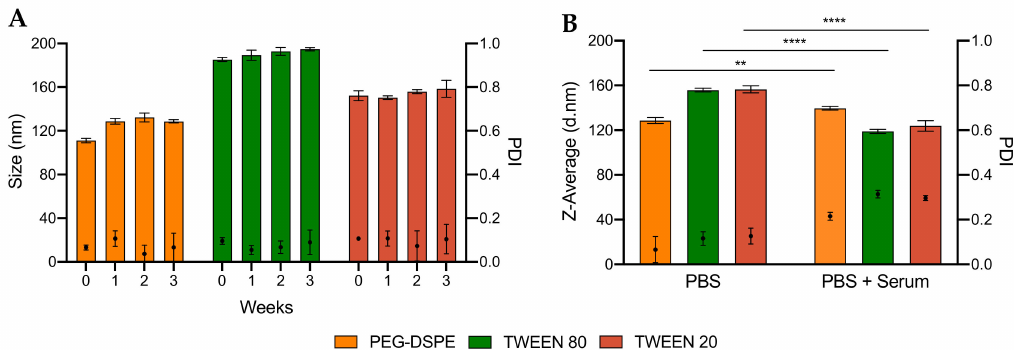
Figure 4. Stability of LNPs PEGylated with 1.5% PEG-DSPE, Tween 80 and Tween 20 ( A ) over 3 weeks and ( B ) in mouse serum. One-way ANOVA was performed on graph B, followed by Turkey’s test for multiple comparisons. ** p < 0.01; **** p <